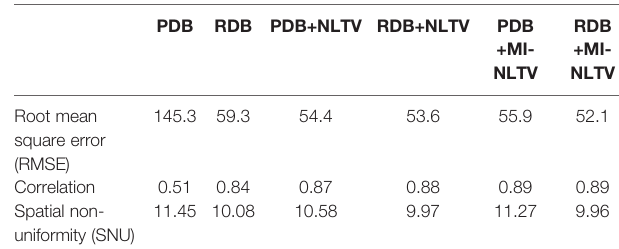
TABLE 3 | Quantitative comparisons based on three metrics in the CBCT image generated by six analytical reconstruction algorithms using low-dose projection data of the Catphan ® 503 phantom.